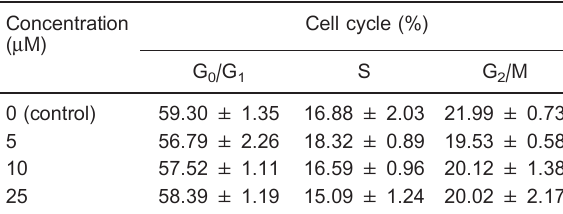
Table 1. Effect of ziyuglycoside II on cell cycle distribution of BGC-823 cells after a 24-h treatment. Concentration ( m M)